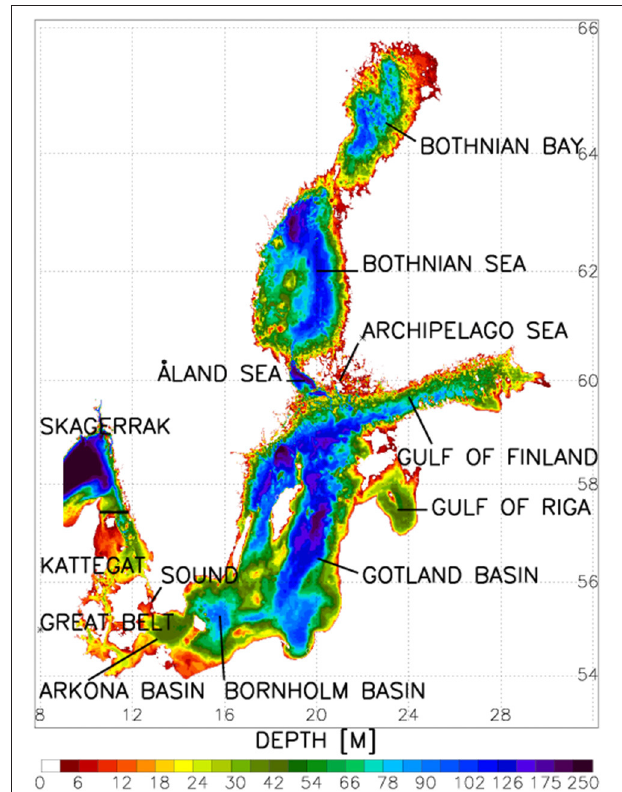
FIGURE 1 | Bottom topography of the Baltic Sea. The Baltic proper comprises the Arkona Basin, Bornholm Basin and Gotland Basin. The solid line marks the border between Kattegat and Skagerrak which is the lateral boundary in BALTSEM and other Baltic Sea models (see